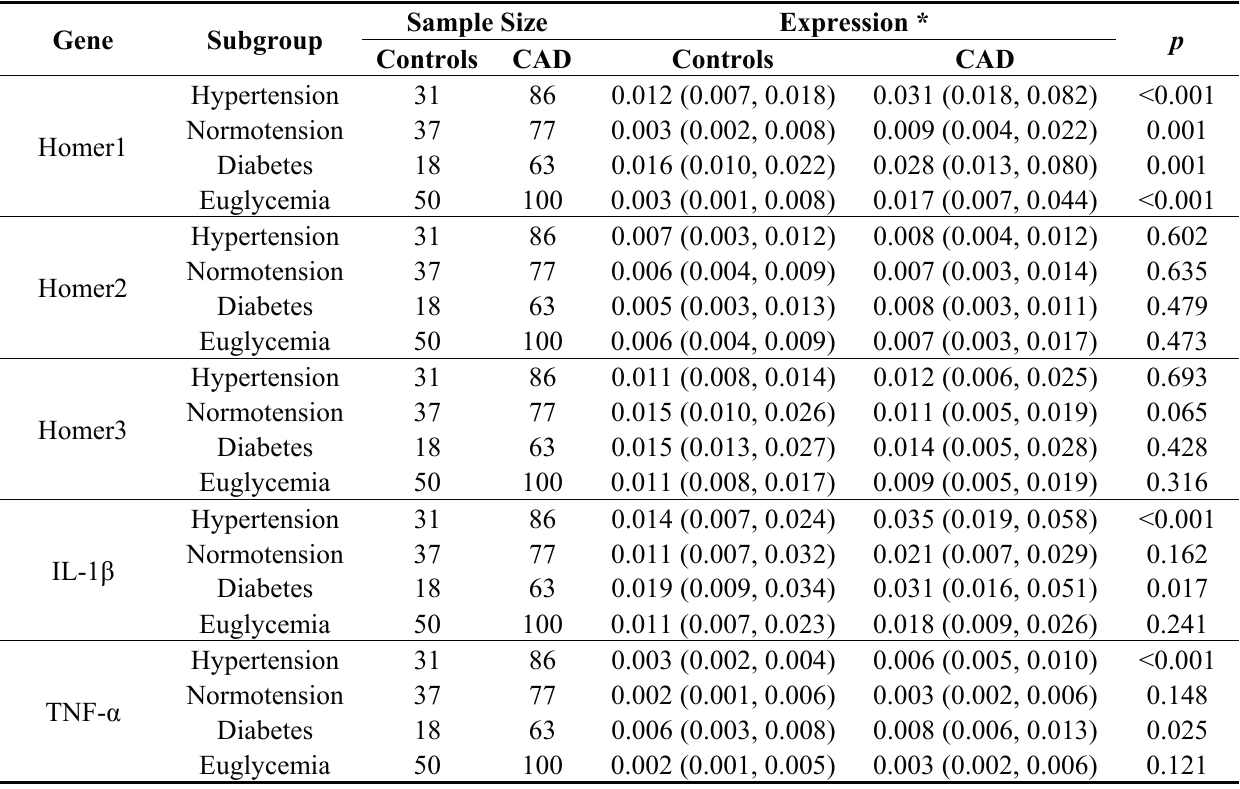
Table 2. Subgroup analyses of the gene expression of Homer1, Homer2, Homer3, IL-1 β , and TNF- α between CAD patients and controls by hypertension and diabetes.